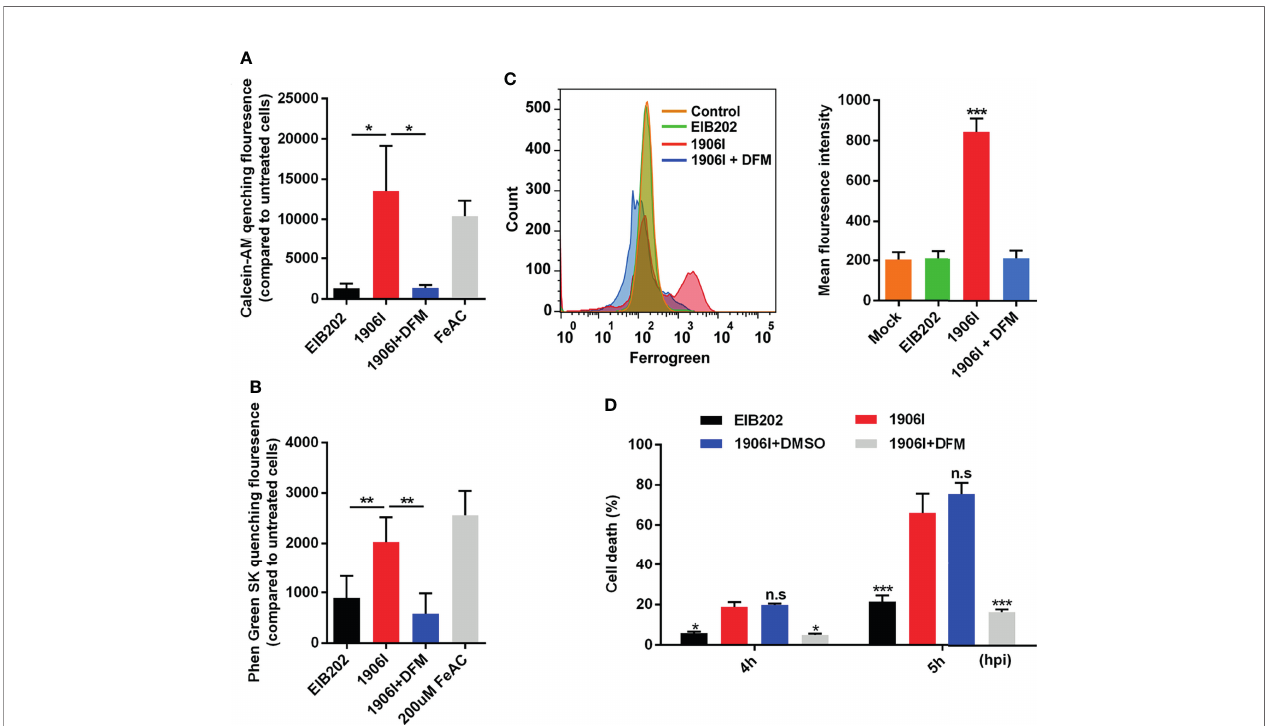
FIGURE 4 | C-di-GMP-upregulated E. piscicida promoted cytosolic and mitochondrial labile iron accumulation triggering an iron-dependent cell death. (A, B) Calcein-AM (A) and Phen Green SK (B) quenching fl uorescence intensity of HeLa cells treated with indicated E. piscicida strains or 200 µM ferric ammonium citrate (FeAC) with or without deferoxamine mesylate (DFM, 50 µM) for 3 h when compared to cells incubated with Opit-MEM only. Fluorescence intensity of cells was measured with a Multiscan Spectrum microplate reader and quenched fl uorescence intensity compared to untreated cells re fl ected the cytosolic labile iron content. (C) Flow cytometric detection of mitochondrial labile iron in HeLa cells infected with E. piscicida EIB202 or 1906I with or without DFM (50 µM) by mitochondria-speci fi c fl uorescent probe Mito-FerroGreen. (D) LDH release of HeLa cells infected with E. piscicida EIB202 or 1906I at an MOI of 25 for the indicated time in the presence of DFM (50 µM) or DMSO. Results are representative of at least three independent experiments, and error bars denote SD of triplicate wells. * P < 0.05, ** P < 0.01, *** P < 0.001; n.s, not signi fi cant. [One-way ANOVA for panels (A – C) , Two-way ANOVA for panel (D)